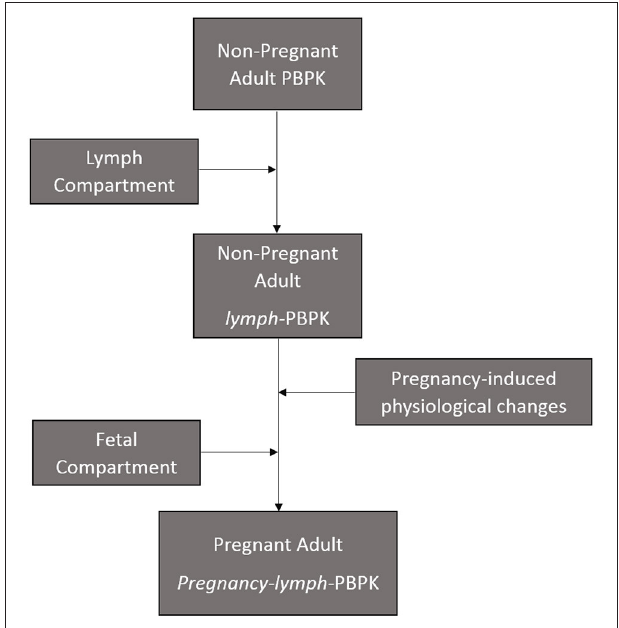
FIGURE 1 | PBPK Model development workflow